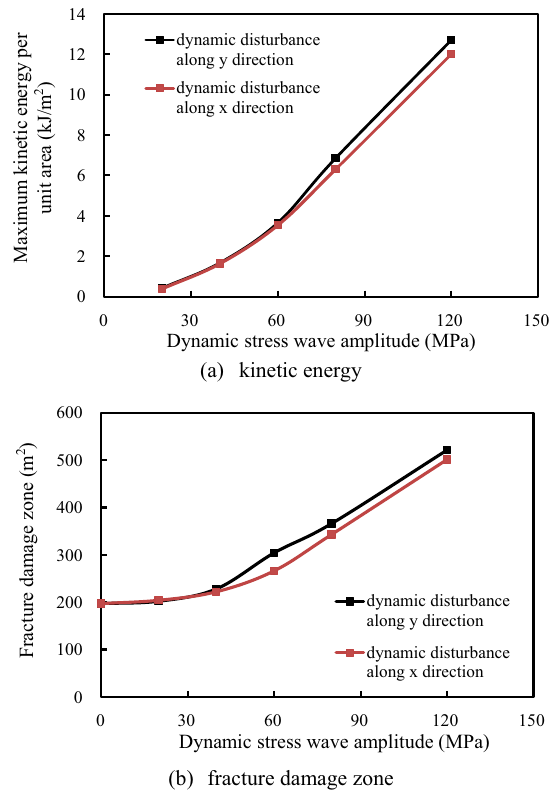
Fig. 14 Maximum kinetic energy per unit and fracture damage zone distribution as functions of dynamic stress-wave amplitudes. Note: y direction indicates vertical direction, and x direction indicates hori-